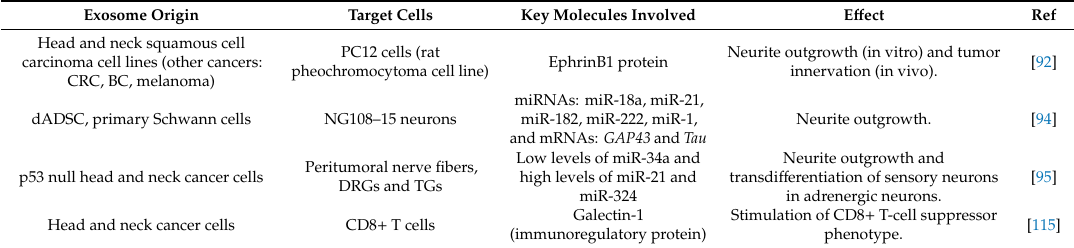
Table 3. Exosomes as a communication tool between nerves and cancer cells and between immune and cancer cells, and the consequently generated e ff